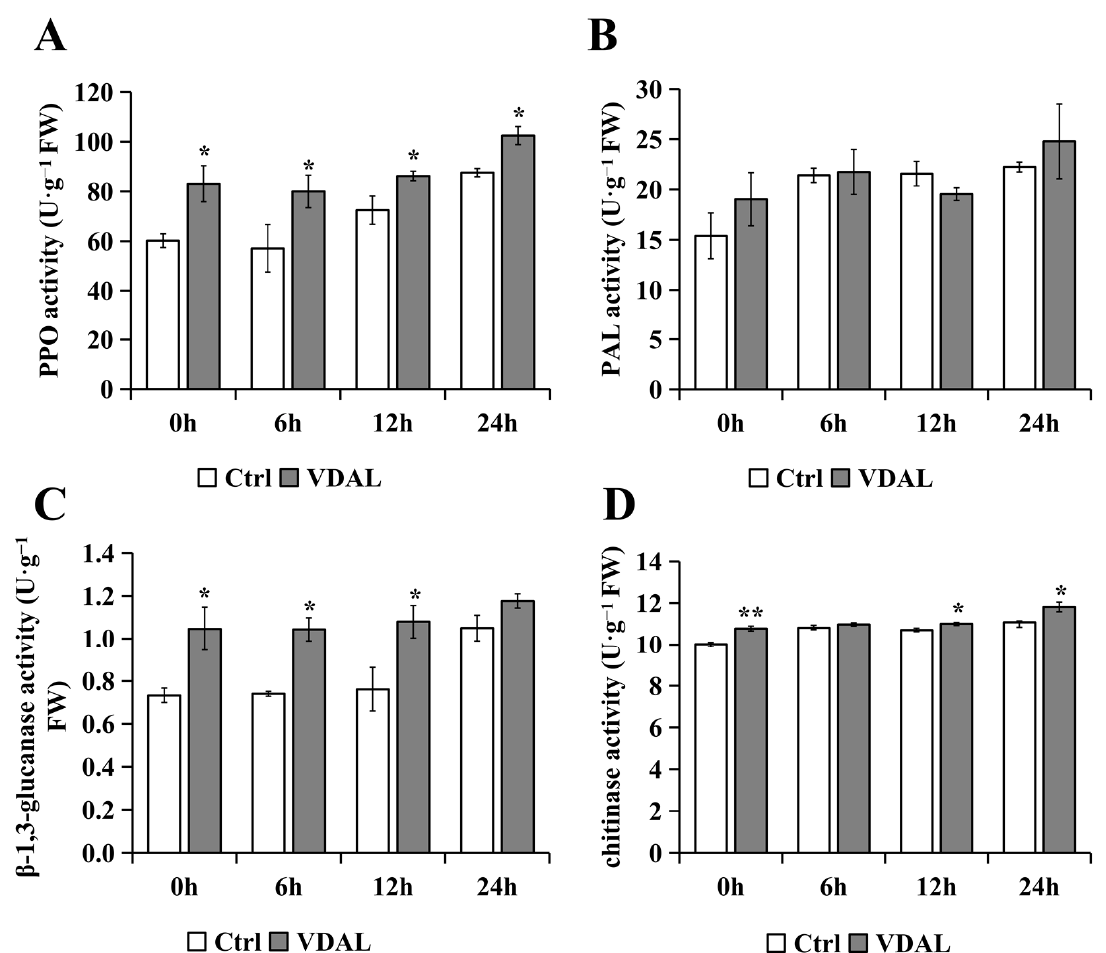
Figure 4. Defense-related enzyme activities of B. rapa inoculated with S. sclerotiorum after spraying with water or 1 g · L − 1 VDAL. ( A ) PPO activity of B. rapa at 0, 6, 12, and 24 h after inoculation. ( B ) PAL activity of B. rapa at 0, 6, 12, and 24 h after inoculation. ( C ) β -1,3-glucanase activity of B. rapa at 0, 6, 12, and 24 h after inoculation. ( D ) Chitinase activity of B. rapa at 0, 6, 12, and 24 h after inoculation. Three independent replicates were performed. Student’s t -test (* p < 0.05; ** p < 0.01) was used to estimate significant effects.